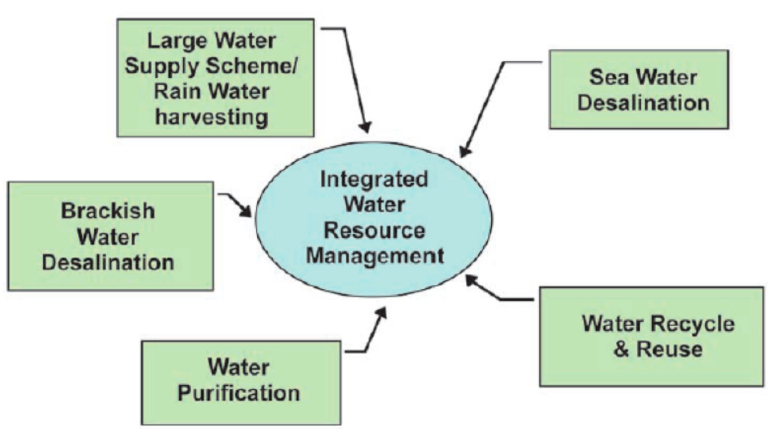
Figure 8. Integrated water resource management through desalination and recycle and reuse of water.